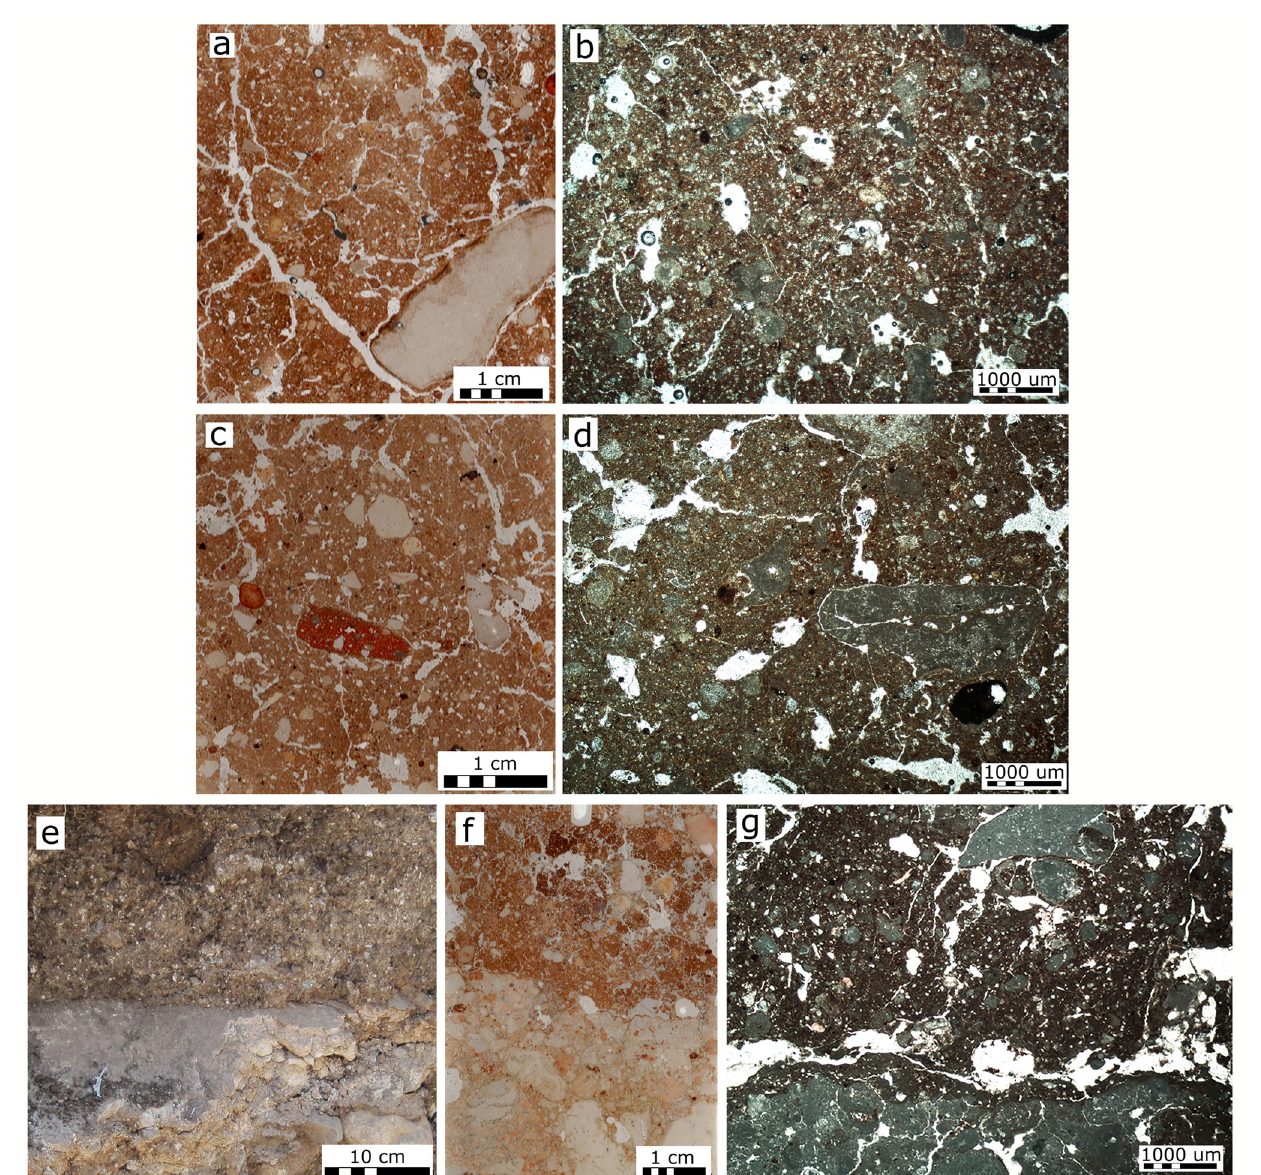
Fig 6. Results of micromorphology analysis. (a) Scan of thin section of a mudbrick from a Phase III wall (sample KAB-2450.5 in S2 Table). (b) Microphotograph of a Phase III mudbrick (sample KAB-2450.5 in S2 Table). (c) Scan of thin section of the fill deposit (5–11 cm) above the palaces’ Phase III floor (sample KAB-B2 in S2 Table). The red particles are pottery sherds. (d) Microphotograph showing the general appearance of the fill deposit shown in (c). (e) Field photo showing the Phase III plaster floor of Room 2553 and the fill deposit covering it. (f) Scan of thin section of the contact shown in (e) (sample KAB-2603.13 in S2 Table). (g) Microphotograph showing the contact between the floor and sediment lying directly on it shown in